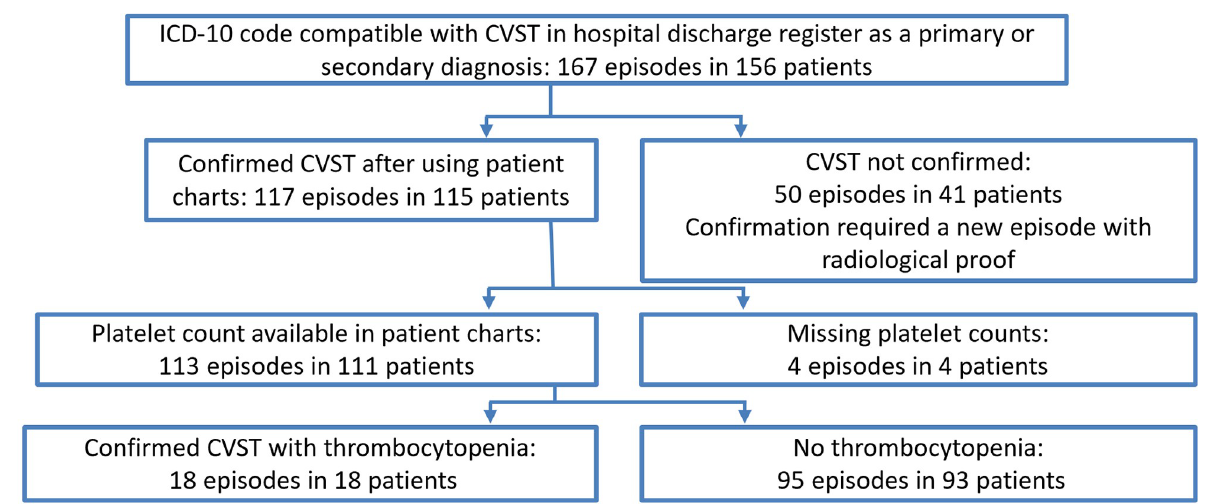
Fig 1. Flow chart. From top to bottom shows the extraction of confirmed cerebral venous sinus thrombosis (CVST) in combination with thrombocytopenia. Note that three register-based CVST episodes, one of which confirmed, are included here but occurred after the risk periods and were not included in the pre-vaccinated